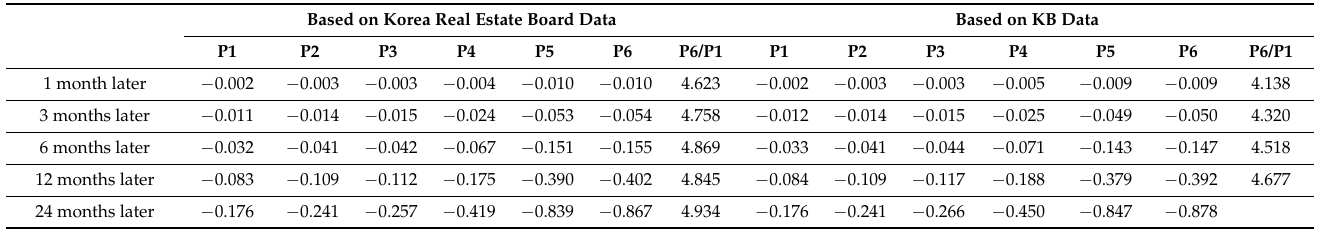
Table 5. Analysis of the Cumulative Impulse Response Function of Time Variable hen Interest Rates are